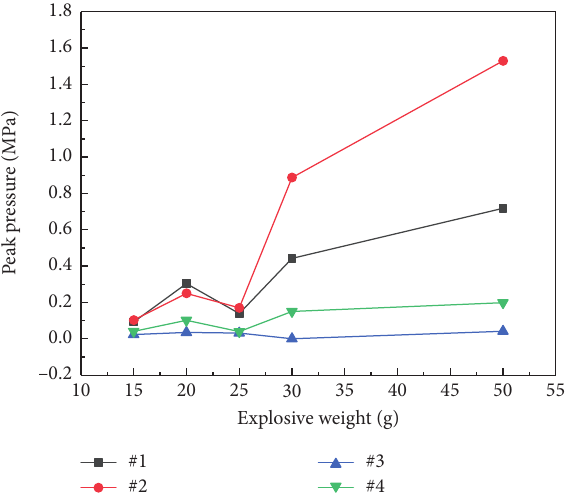
Figure 19: The peak pressure under close-in explosions with different explosive mass.